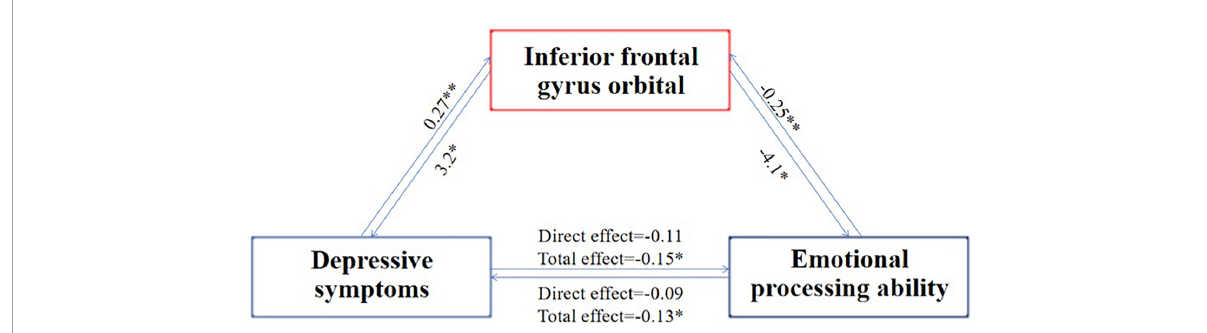
FIGURE1 Mediating process of the common brain structure between emotion recognition ability and depressive symptoms. N = 995; the index of emotion recognition ability is the average reaction time of each test during the completion of the emotion recognition task, and the index of depression symptom is the score on the depression syndrome scale. The number on the arrow indicates the mediating effect coefficient, ∗ indicates that the p -value is less than 0.05, and ∗∗ indicates that the p -value is less than 0.01. The picture shows that the aggravation of depressive symptoms increases the thickness of the cortex of the inferior frontal gyrus orbital part, which in turn deteriorates the ability for emotional recognition, which in turn further increases the thickness of the cortex of the inferior frontal gyrus orbital part, which in turn aggravates the symptoms of depression.